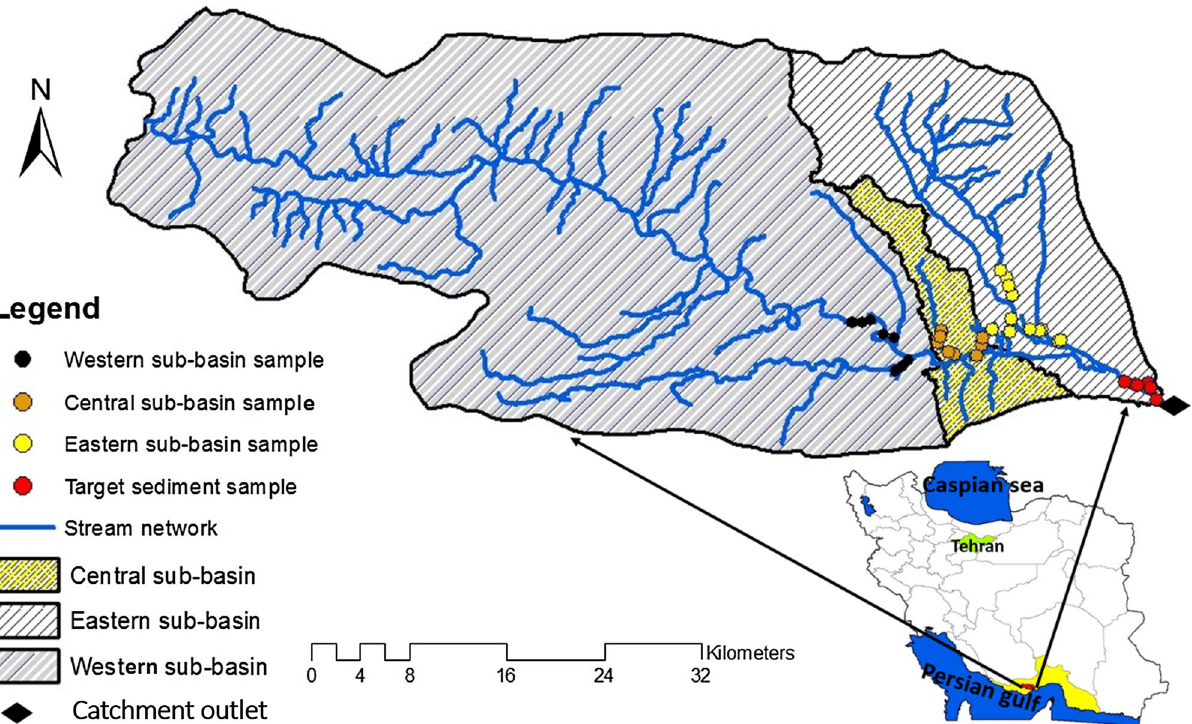
Figure 1. Location of the sub-basin and catchment outlet sediment sampling sites in the study area in Hormozgan province, Iran. The red and yellow shading in the bottom map indicate the study catchment and Hormozgan province, respectively. This map was generated in ArcGIS 10.4.1 (https:// www. esri. com/ en- us/ about/ about- esri/ overv